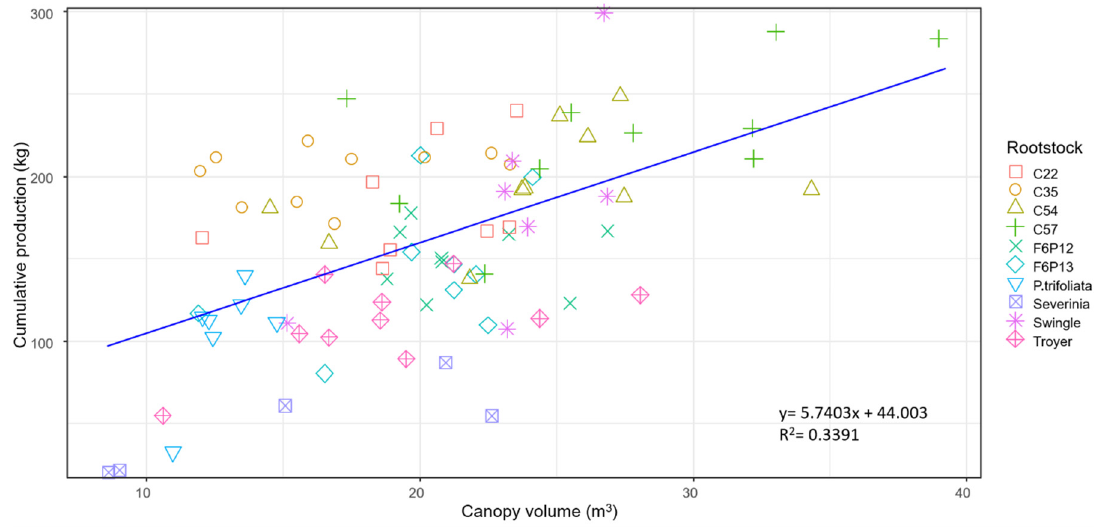
Figure 4. Scatterplot with regression line showing the relationships between canopy volume and cumulative production of the single replicate trees.